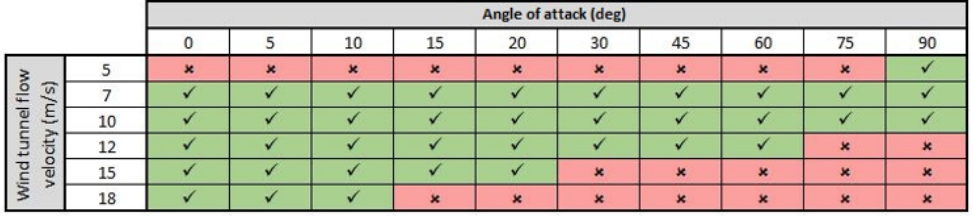
Figure 5. Matrix indicating which experiments were performed in the wind tunnel. Valid for all three motor configurations (D, M, R) defined as part of the experiments. Each cell corresponds to a single experimental